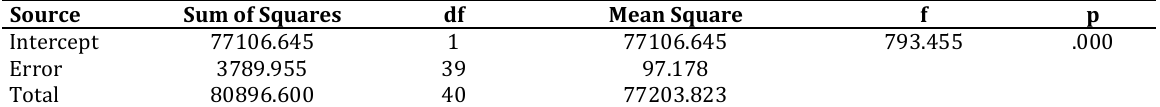
Table 4 Independent T-Test Results Variable